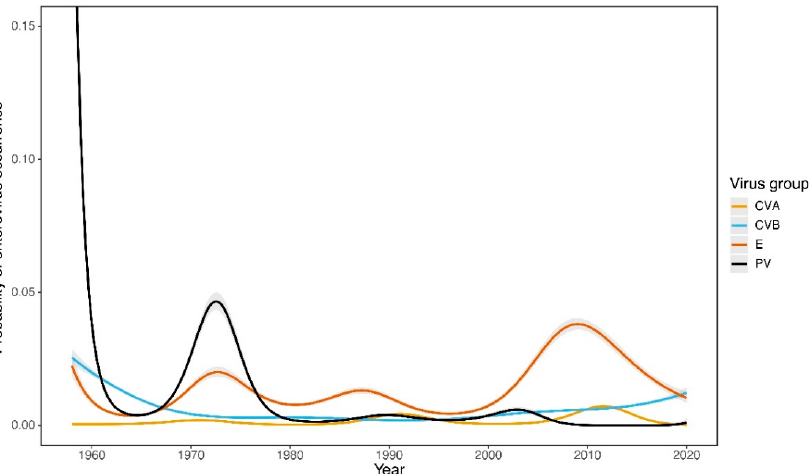
Figure 1. Temporal trends in probability of enterovirus occurrence in the Slovak Republic from 1958 to 2020. GAM-based estimates (lines) are displayed along with 95% confidence intervals.